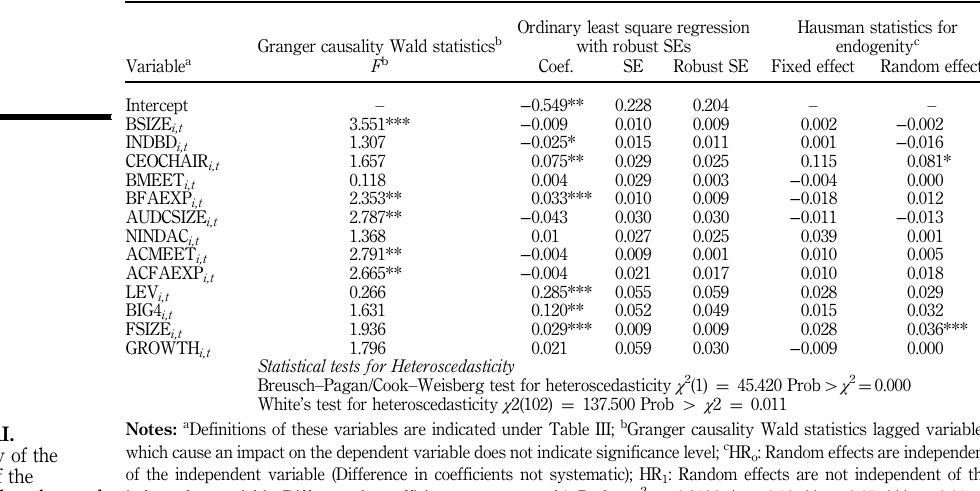
Table AI. Summary of the results of the statistical analyses of